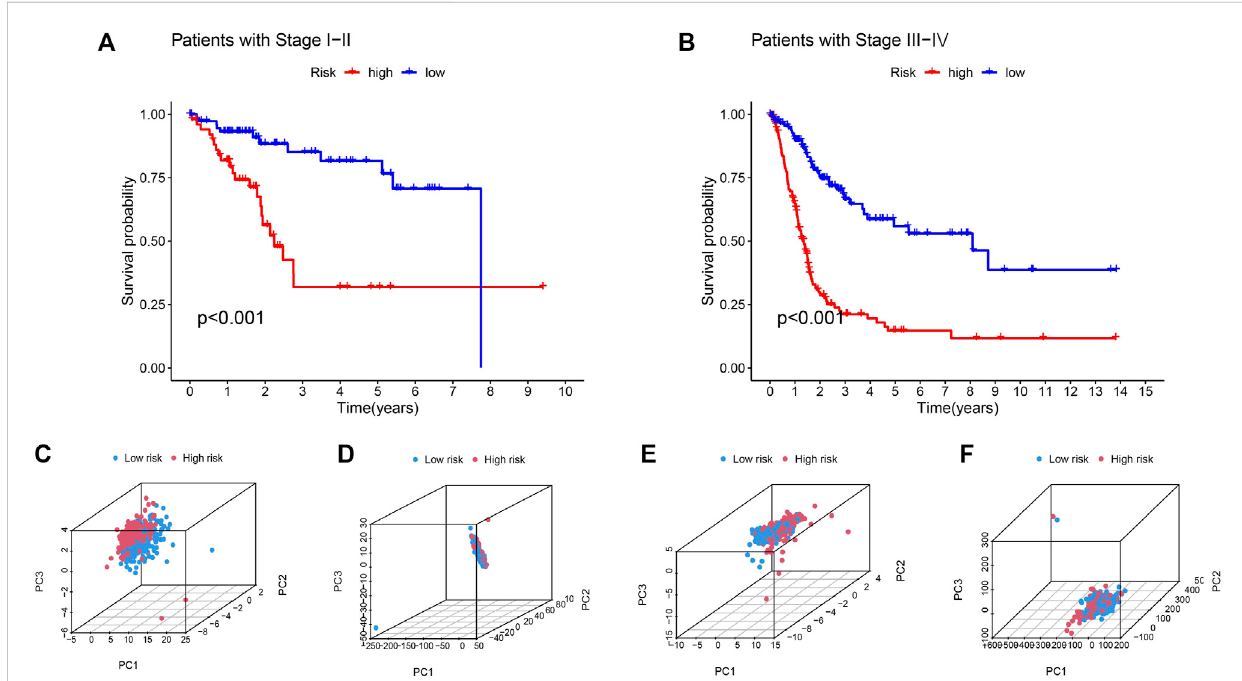
FIGURE 5 Kaplan-MeiersurvivalcurvesbyclinicopathologicalvariablesandPCAofdifferentgenesetsperformedforpatientriskclassi fi cation.Stage (A) Ⅰ - Ⅱ , (B) Ⅲ - Ⅳ . PCA of low- and high-risk groups based on (C) CupRLSig model risk lncRNAs, (D) cuproptosis-related lncRNAs, (E) cuproptosis-related genes, and (F) all-genes. Red represents patients with high-risk scores and blue represents patients with low-risk